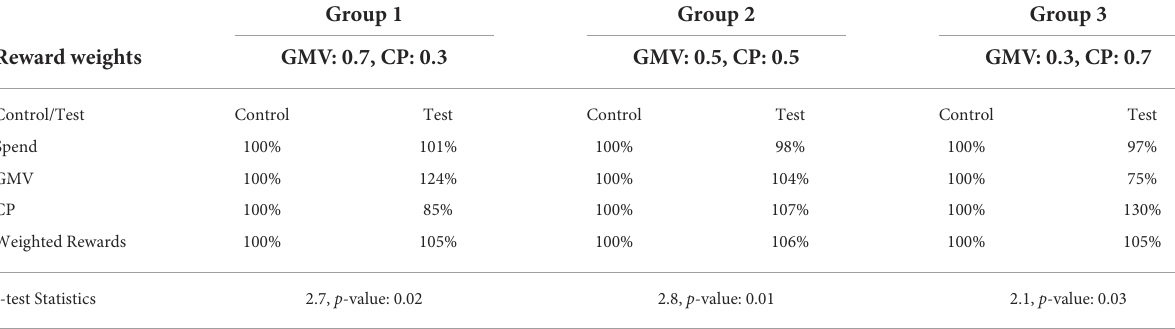
TABLE 6 Results for 3 online AB tests regarding 3 different reward weights. Group